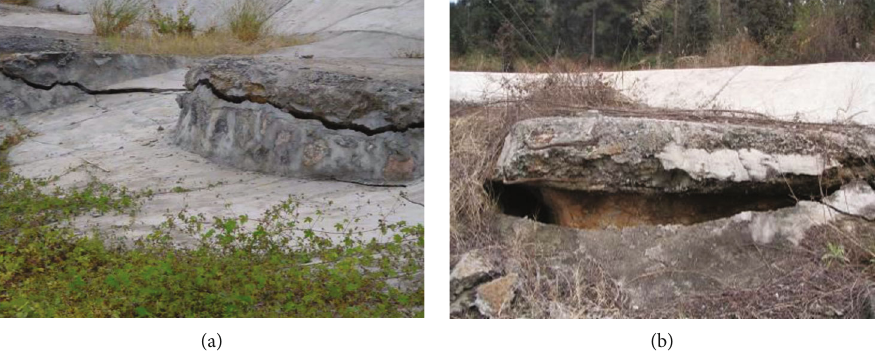
Figure 2: (a) Crack behind the piles of the third step in 2003. (b) Crack behind the piles of the third step in